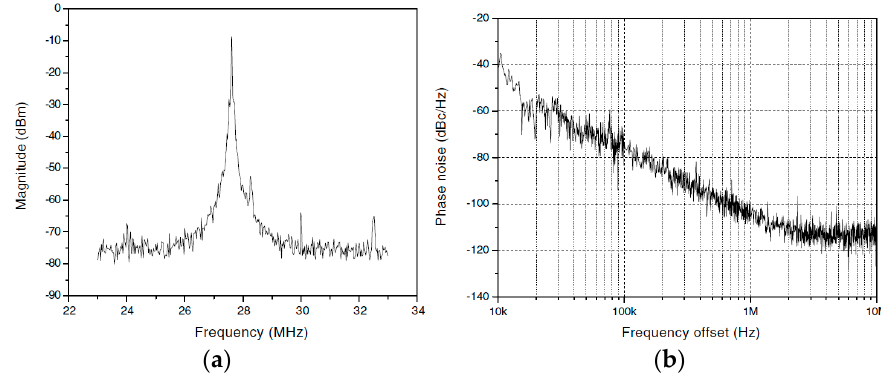
Figure 23. A 27 MHz MEMS resonator oscillator ( a ) output spectrum and ( b ) phase noise plot [232]. © IOP Publishing. Reproduced with permission. All rights reserved. © IOP Publishing. Reproduced with permission. All rights